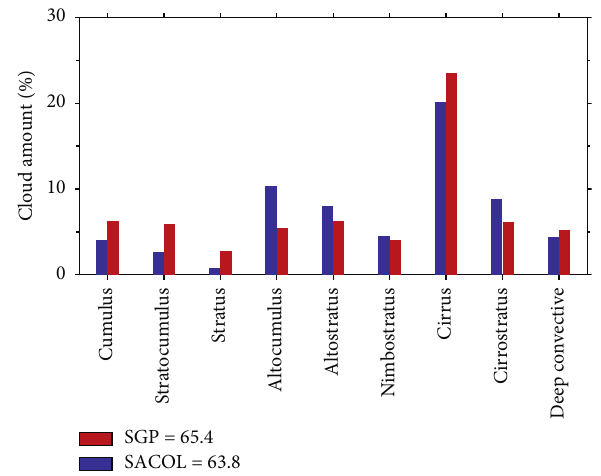
63.8SGP = 65.4 SACOL = Figure 2: ISCCP cloud amounts for different cloud types at the SGP (red bars) and SACOL (blue bars) sites. Data are from 1980 to 2010. Mean cloud amounts at each site are given in the upper left